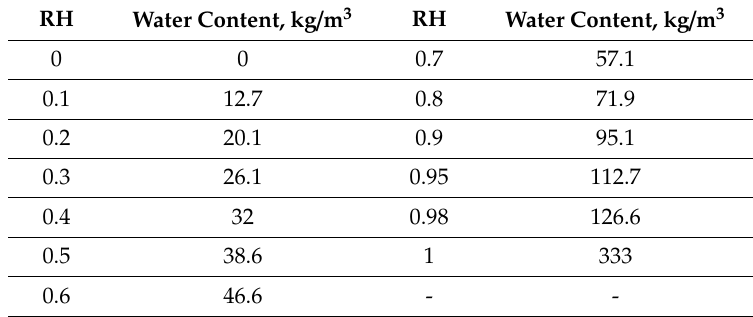
Table A14. Moisture storage function—improved model.